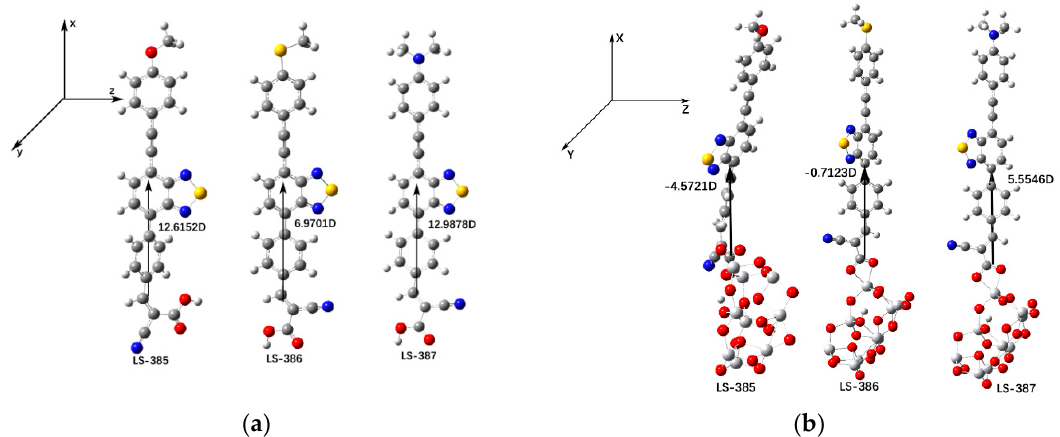
Figure 6. ( a ) Calculated vertical dipole moment µ normol of dye in DMF solvent. ( b ) Calculated vertical dipole moment µ normol of dye/ ( TiO 2 ) complexes in DMF 9